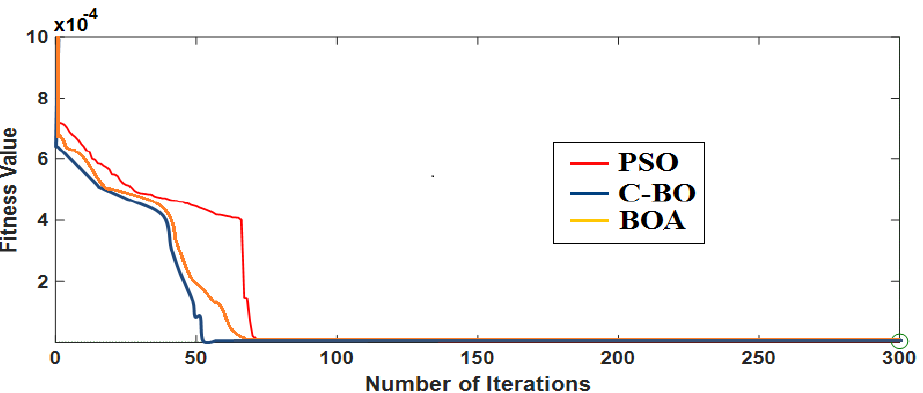
Figure 15. Cost convergence for fuzzy PID over iterations. Table 6. Optimal parameters of the speed regulator.